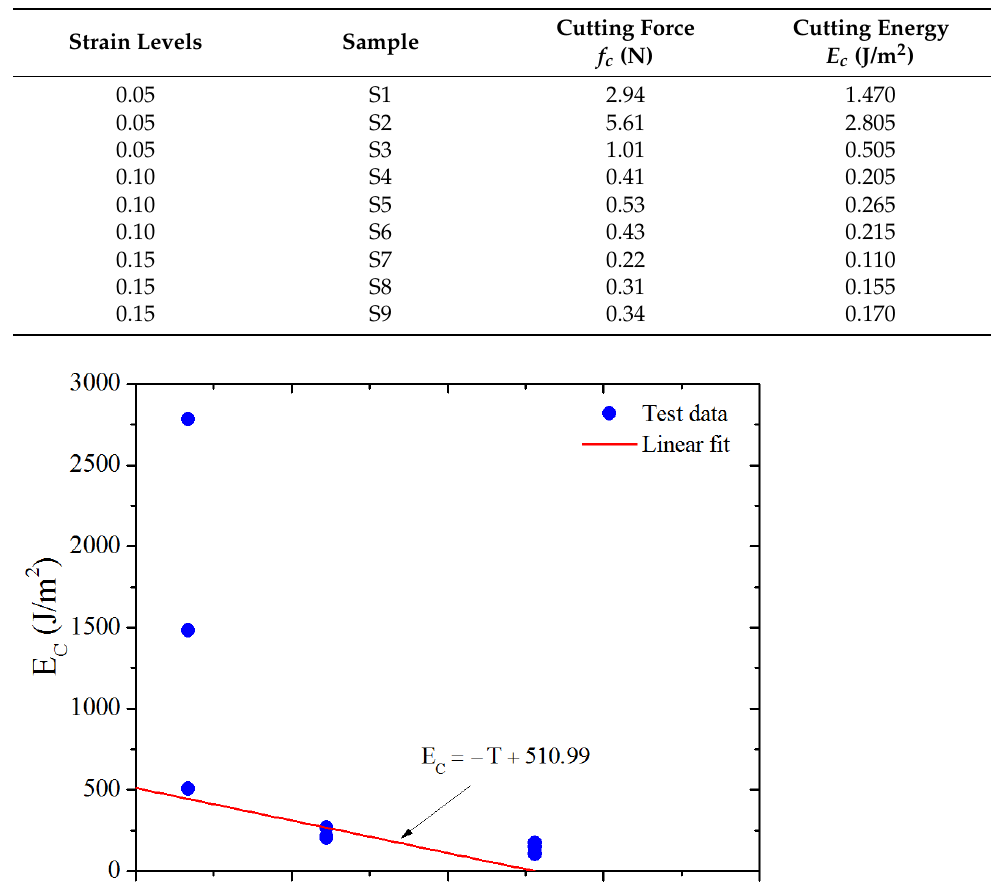
Table 1. Cutting force f c and the corresponding cutting energy E c .